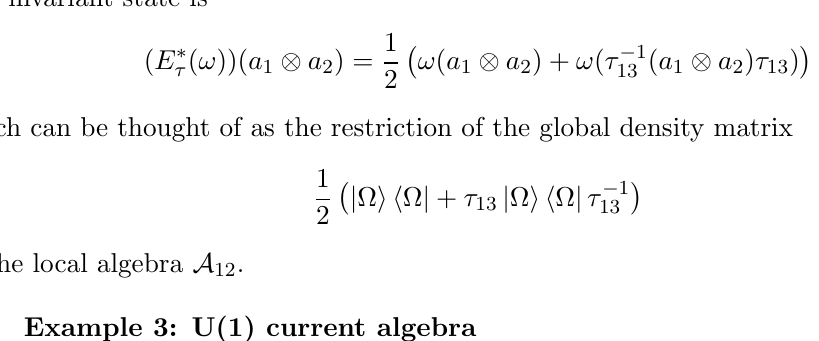
The invariant state